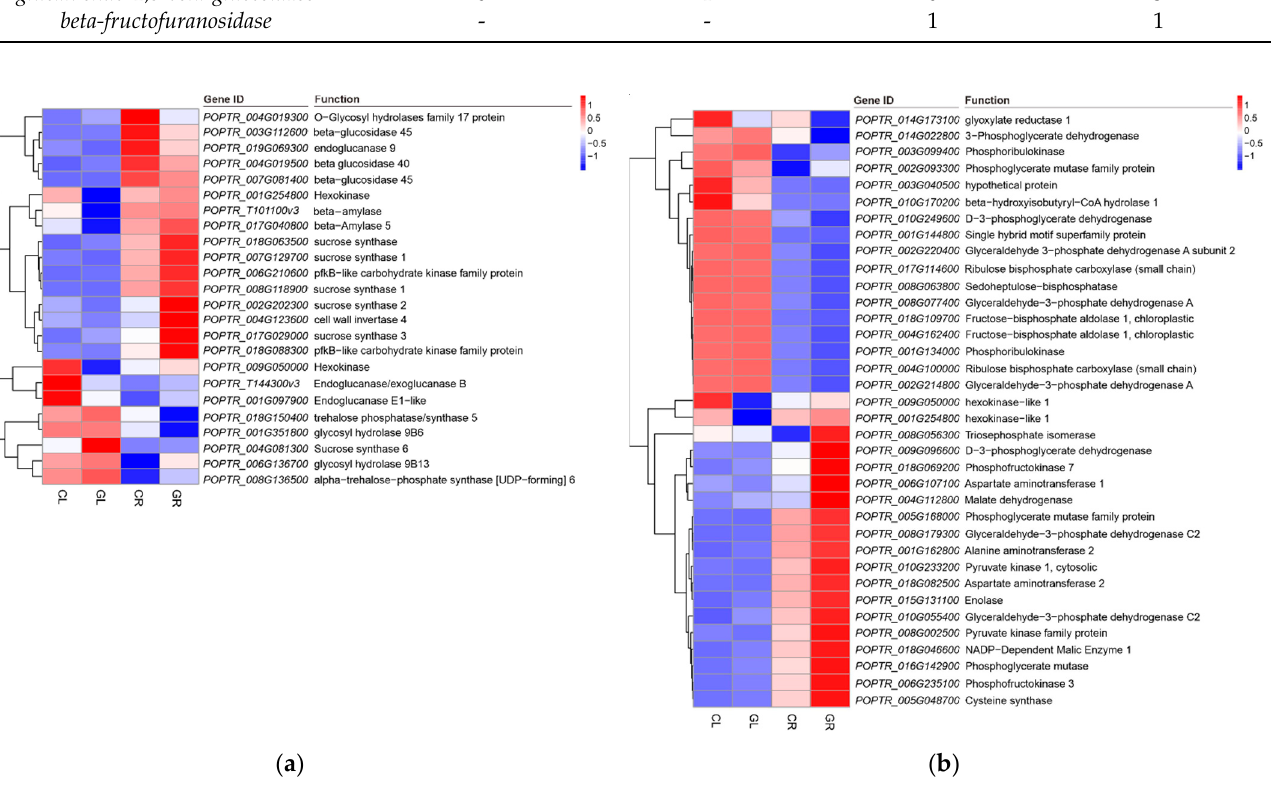
Figure 7. Heatmap of DEGs in starch and sucrose metabolism pathway ( a ) and carbon metabolism ( b ) by the pairwise comparisons of GL vs CL and GR vs CR. CL, CR, GL and GR represent the shoots and roots samples of the inorganic N control and the Gln treatment, respectively.